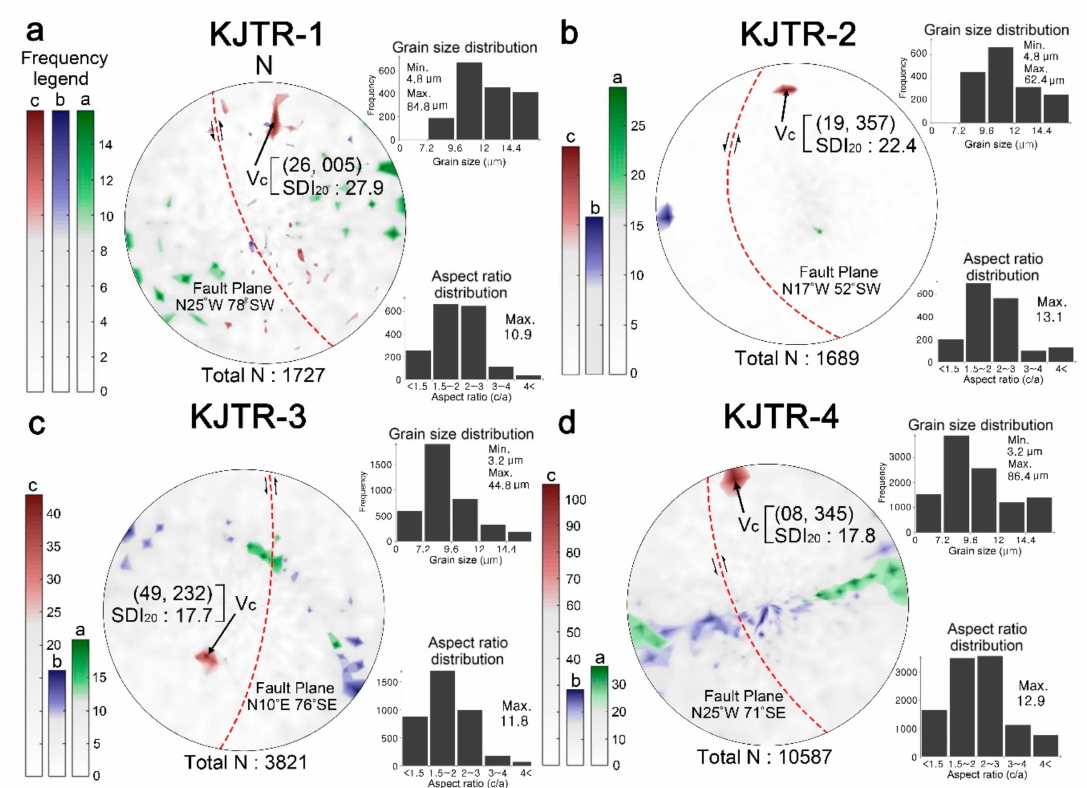
Figure 6. SPO measurements of KJTR samples (KJTR-1, ( a ); KJTR-2, ( b ); KJTR-3, ( c ); KJTR-4, ( d )) shown in stereoplots (lower-hemisphere, equal-area projection). Major axes are shown in red, intermediate axes in blue, and minor axes in green. For all axes, the dip azimuth, dip angle, and SPO distribution index (SDI20) values are given. Histograms show the distribution of grain sizes and aspect ratios. The number of grains analyzed, N, is given at the bottom.